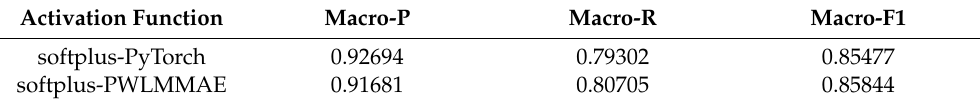
Table 3. Evaluate softplus.